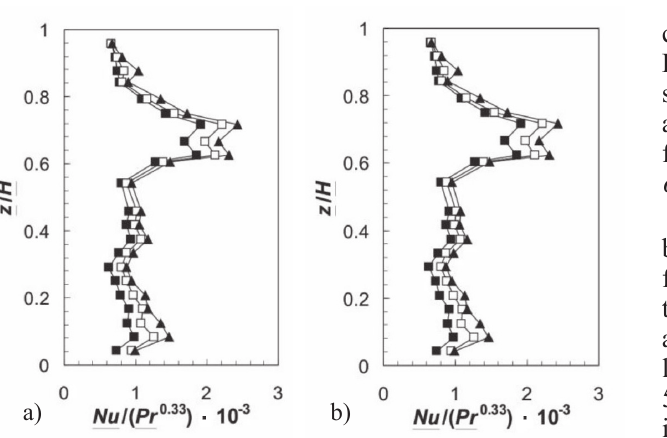
Fig. 9 – Axial distributions of heat transfer coefficient Nu/ (Pr 0.33 ) = f(z/H); liquid: electrolyte; A 315 (lower) – RT (upper); a) w = 0 m s –1 b) w = 5.1 · 10 –3 m s –1 ;  – Re = 30000;  og og